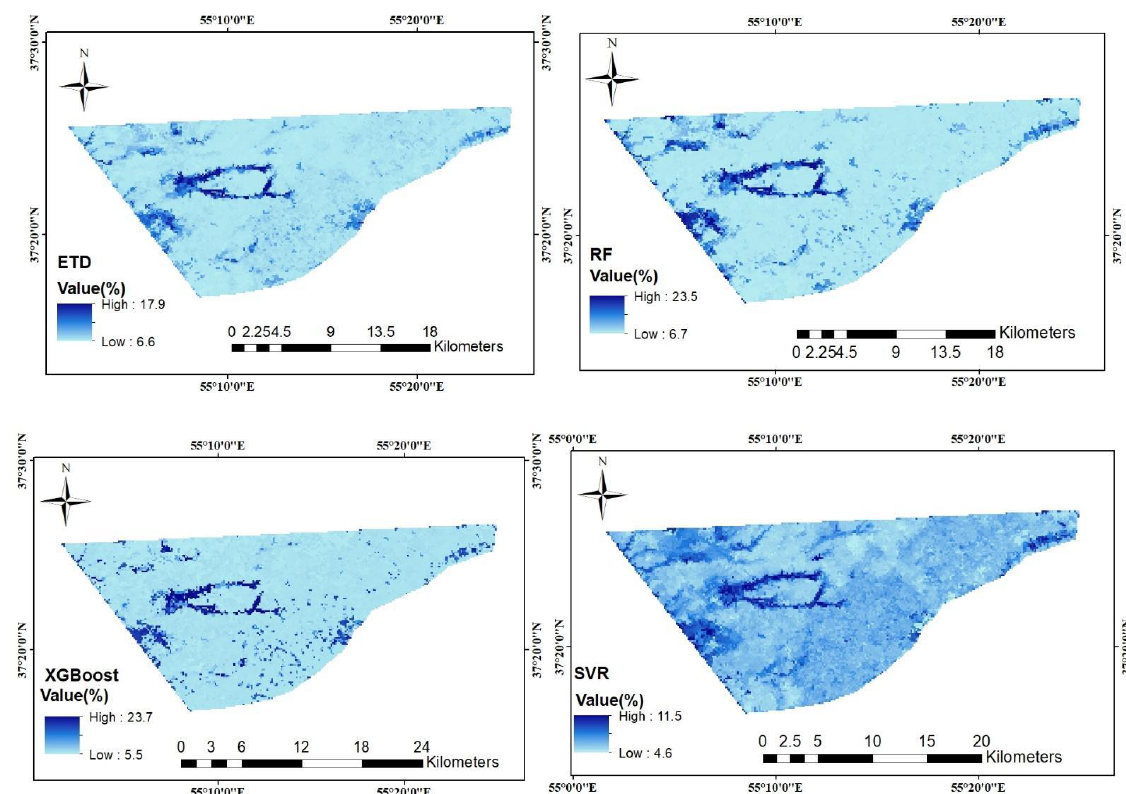
Figure 9. SMC map using Sentinel 2 with RF, XGBoost, SVR, and ETD.